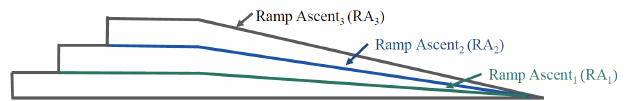
Figure 1. The ramp-stairs module with three adjustable inclination